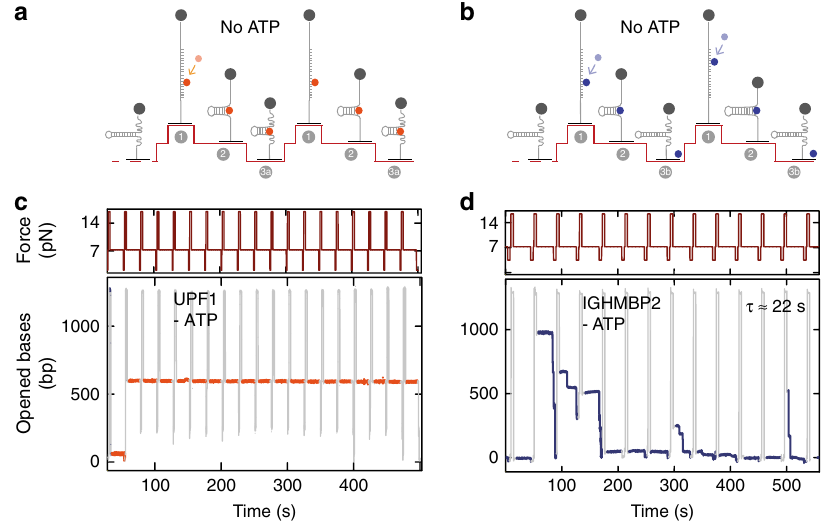
Fig. 2 Single-molecule binding assay (SMBA) to assess helicase binding. a , b Schematic representation of the single-molecule binding assay cycle in absence of ATP. DNA hairpin is initially completely closed. Step 1, a force >15 pN is applied to fully unzip the DNA hairpin which is kept in an open state for 4 s to allow a helicase in solution to bind to the ssDNA. Step 2, force reduction to 7 pN refolds hairpin to its natural state, unless a helicase is bound. Force is held at 7 pN for 20 s leading to helicase residence on substrate over several cycles (3a) or expulsion after one or a few cycles (3b). Step 3, force is reduced <3 pN to check that the hairpin can still completely close. The whole process is repeated several times. c Upf1 remains bound to the substrate at its initial position and blocks hairpin closure over all force cycles. d IGHMBP2 transiently binds then falls off the substrate after one or a few cycles. Values on y -axis in c and d indicate hairpin opening during step 2 of the binding assay described in a and b